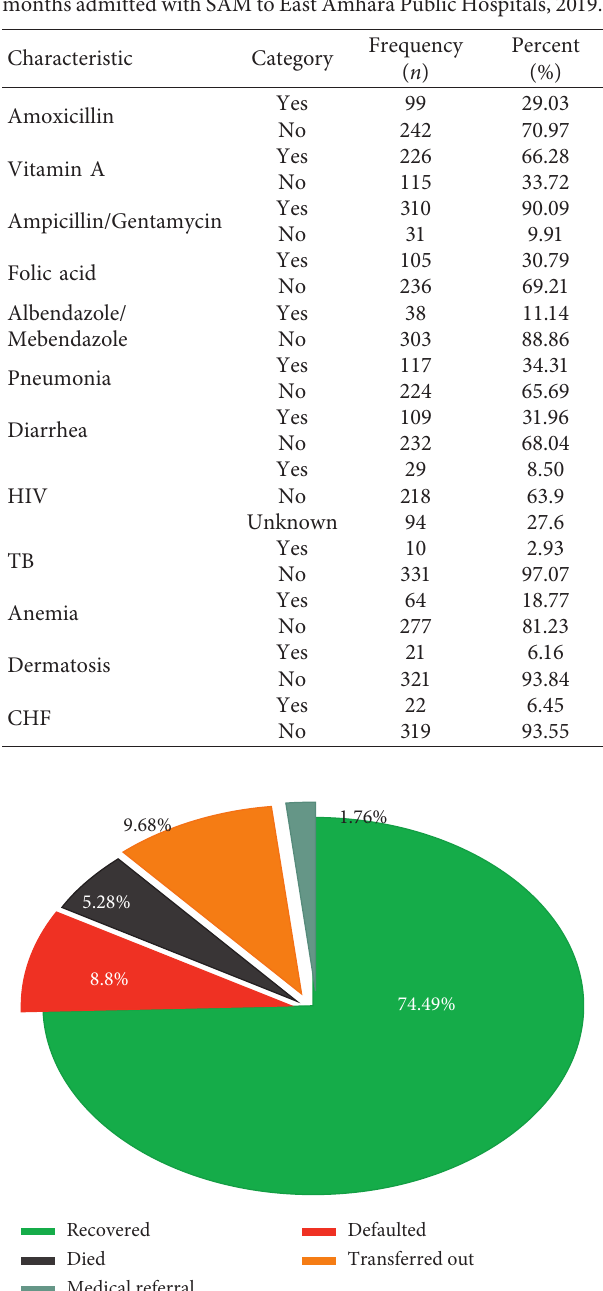
Figure 1: Treatment outcomes of 6–59 months children with severe acute malnutrition in East Amhara Hospitals, Ethiopia,